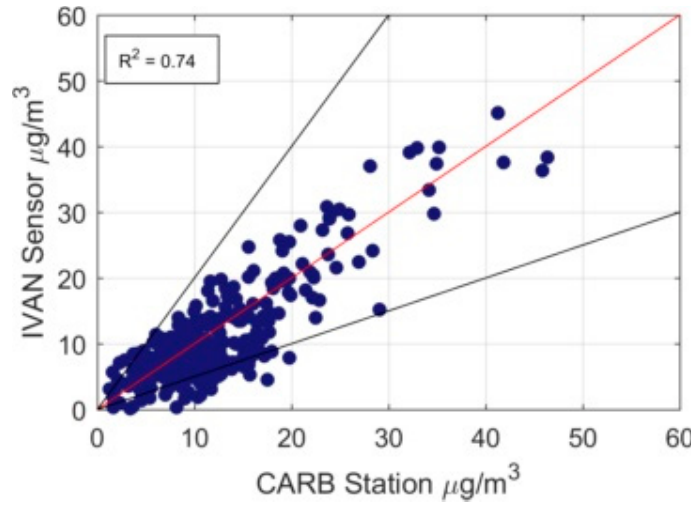
Figure 2. Daily averaged concentrations over the year 2017 of the IVAN sensor in Calexico compared with the regulatory agency Calexico-Ethel St. street station.